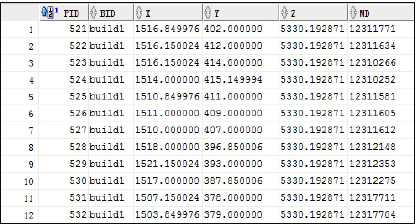
Figure 6. Building Vector Data